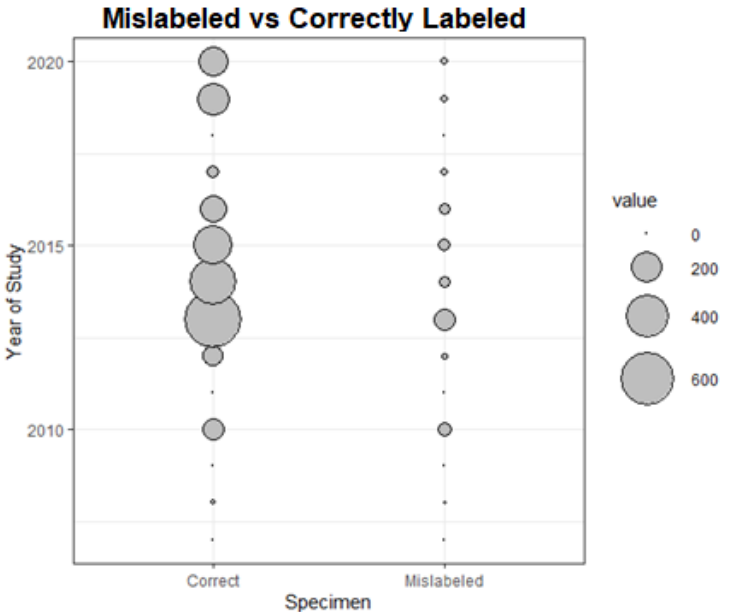
Figure 2. Mislabeled cod products in comparison to correctly labelled products over time within EU countries; value = sample size.